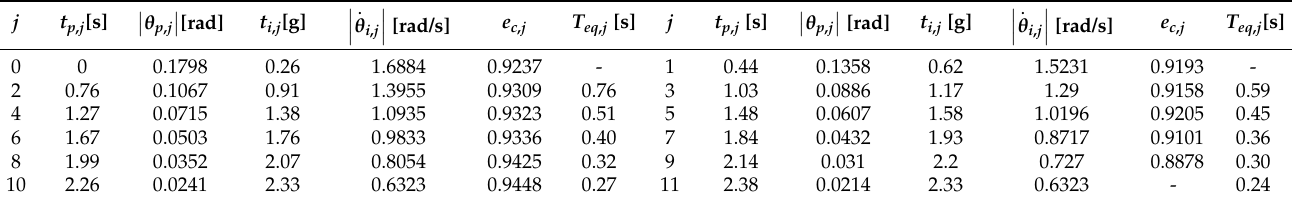
Table 7. Summary of the results of the free oscillation test block type B2.